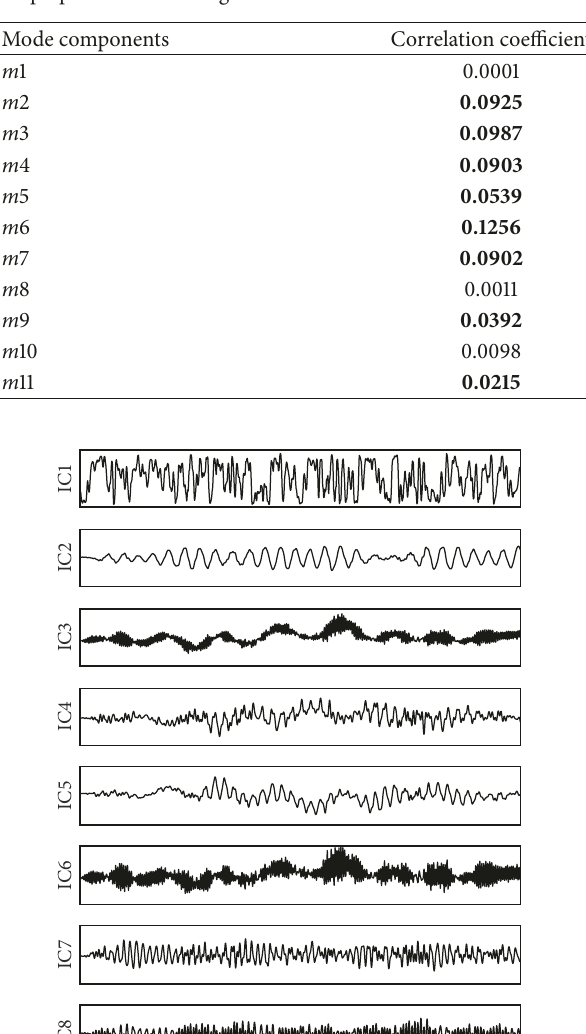
Table 3: Correlation coefficient between the mode components and the preprocessed noise signal.